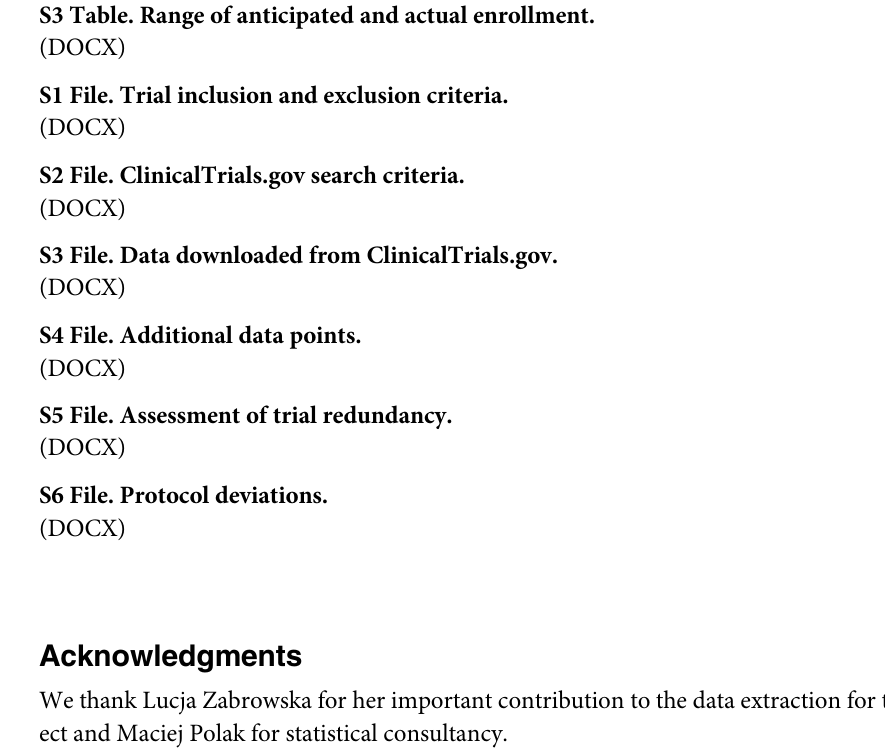
S2 Table. Additional characteristics of trial cohort. S3 Table. Range of anticipated and actual